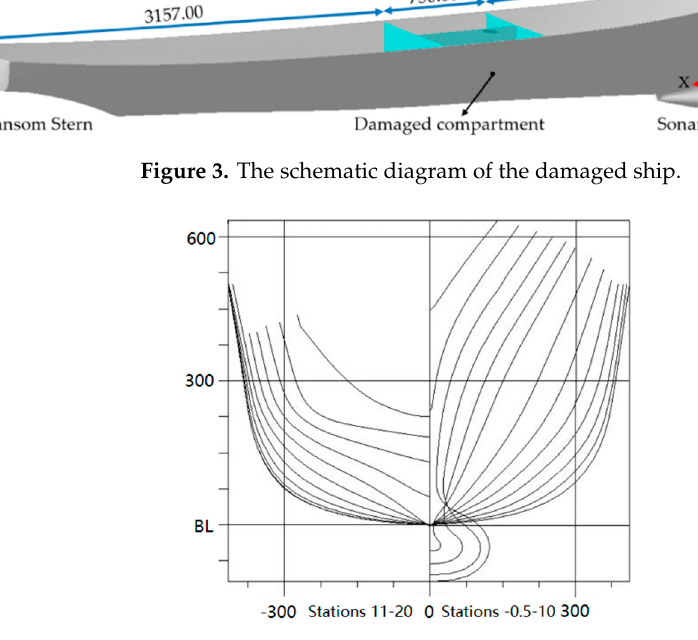
Figure 4. Body lines of DTMB 5415 model (Unit: inch). Table 1. Principal dimensions of the DTMB 5415 model.